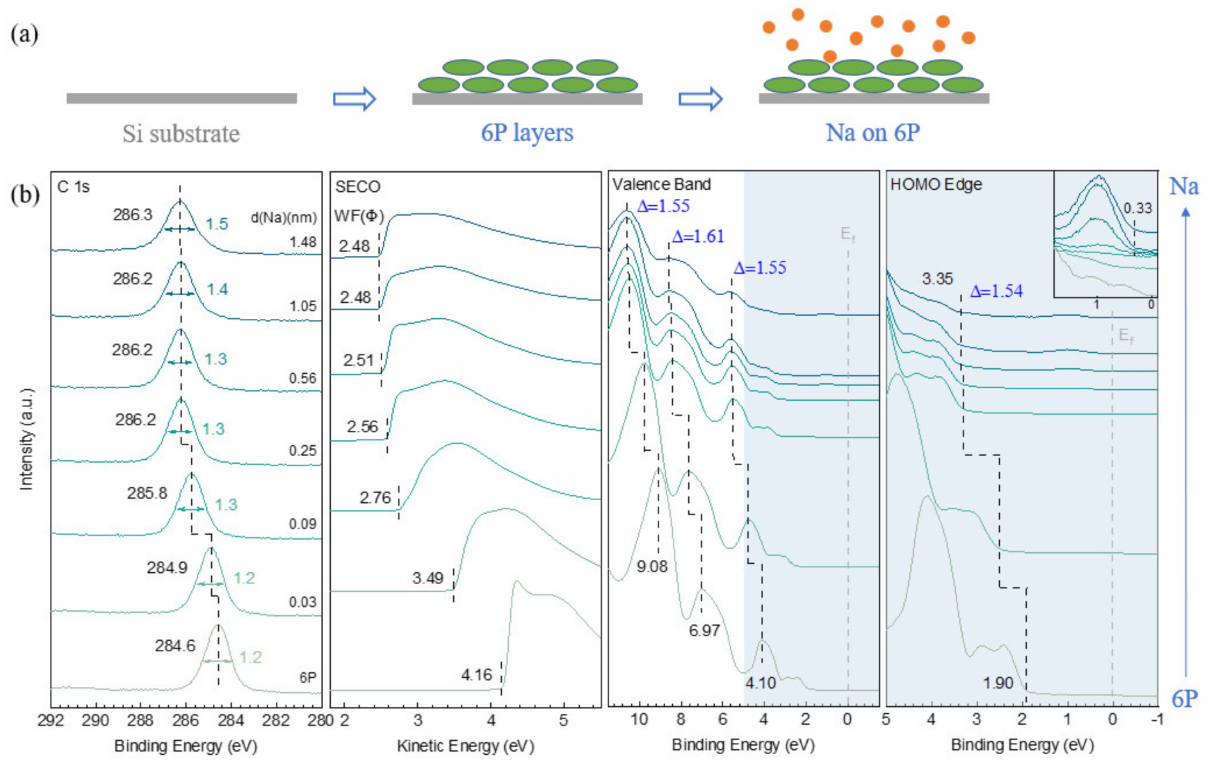
Figure 4. ( a ) Schematic of the 6P molecules and Na atoms deposition sequences. ( b ) XPS and UPS spectra of 6P films with stepwise Na deposition on a silicon